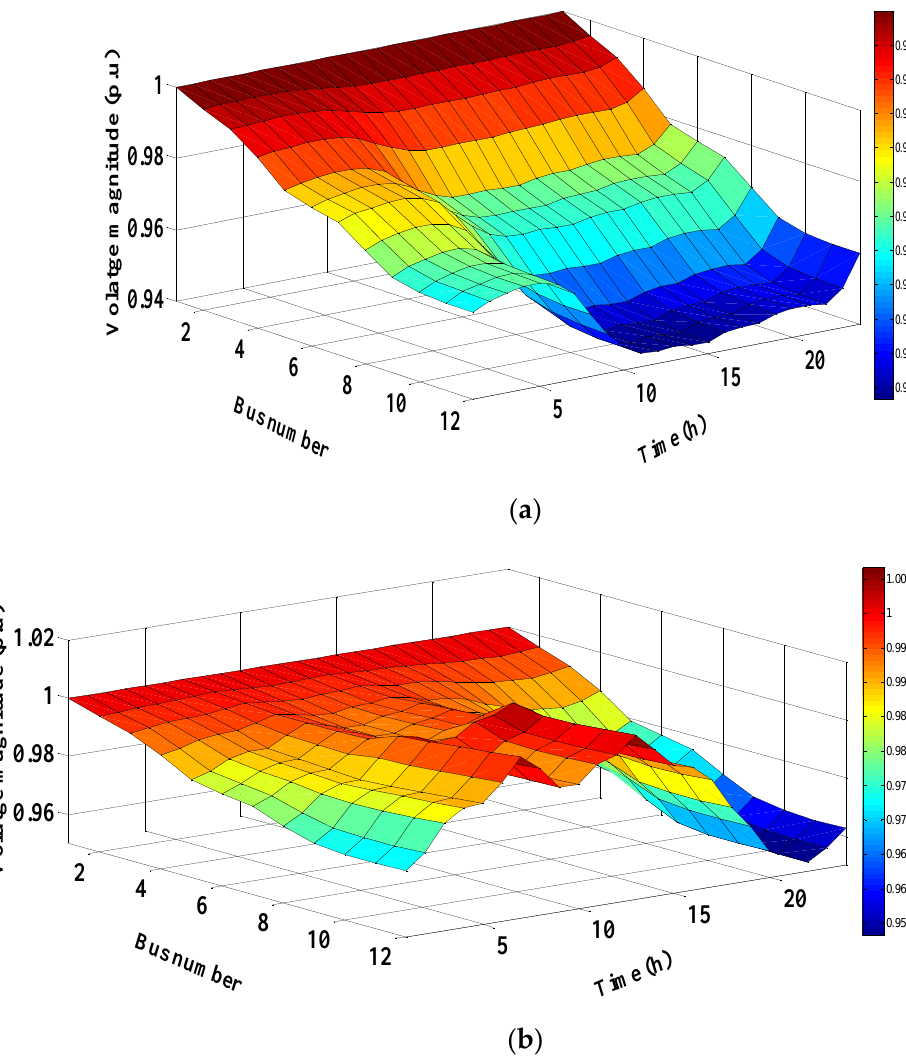
Figure 7. The voltage profile ( a ) without RERs, ( b ) With RERs.